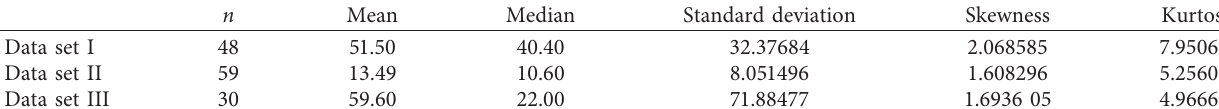
Table 10: Brief description of data sets I, II, and III.